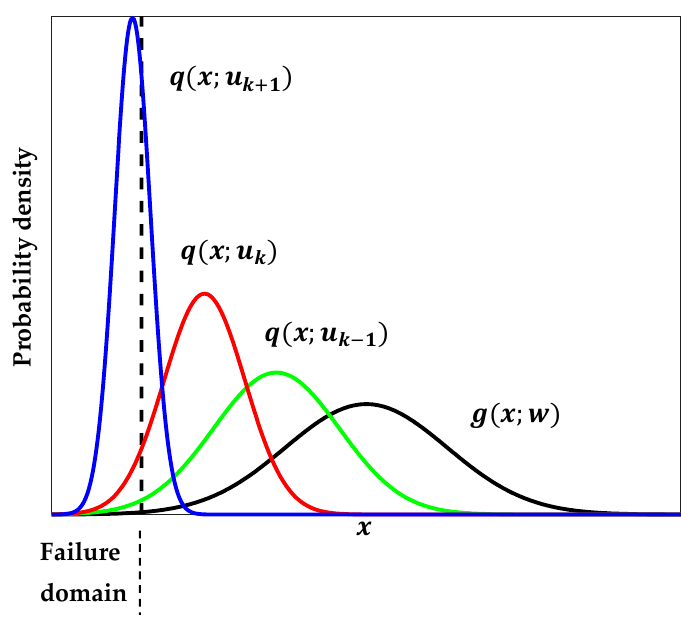
Figure 2. A gradual approach of the sequence of intermediate distributions to the target failure region.